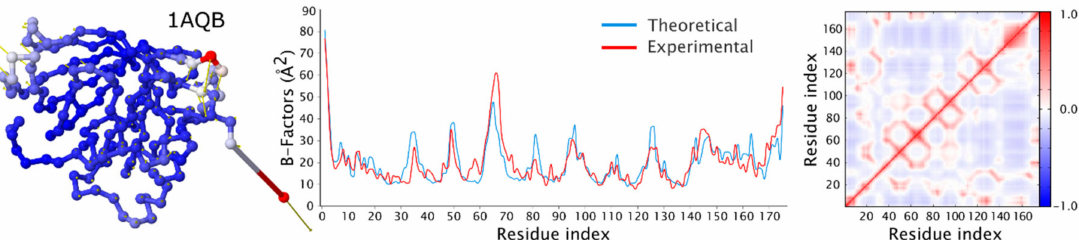
Figure 6. Evaluation of fluctuational dynamics of retinol binding protein (PDB code: 1aqb, chain A) using DynOmics server. First panel shows protein structure with residues represented by balls located at the positions of C α atoms and colored according to the values of B-factors (with red representing highly mobile and blue low mobile residues). Yellow arrows show the direction of oscillation. The chart in the middle compares experimental B-factors (in red) with predicted theoretical values (in blue) as a function of residue index. The effective force constant of the GNM springs is 0.92 k B TÅ − 2 , and corresponding rescaling prefactor is 85.40. Chart on the right shows cross-correlations (CC) between residue fluctuations with the coloring scheme shown on the right (with red denoting highly correlated and blue highly anticorrelated